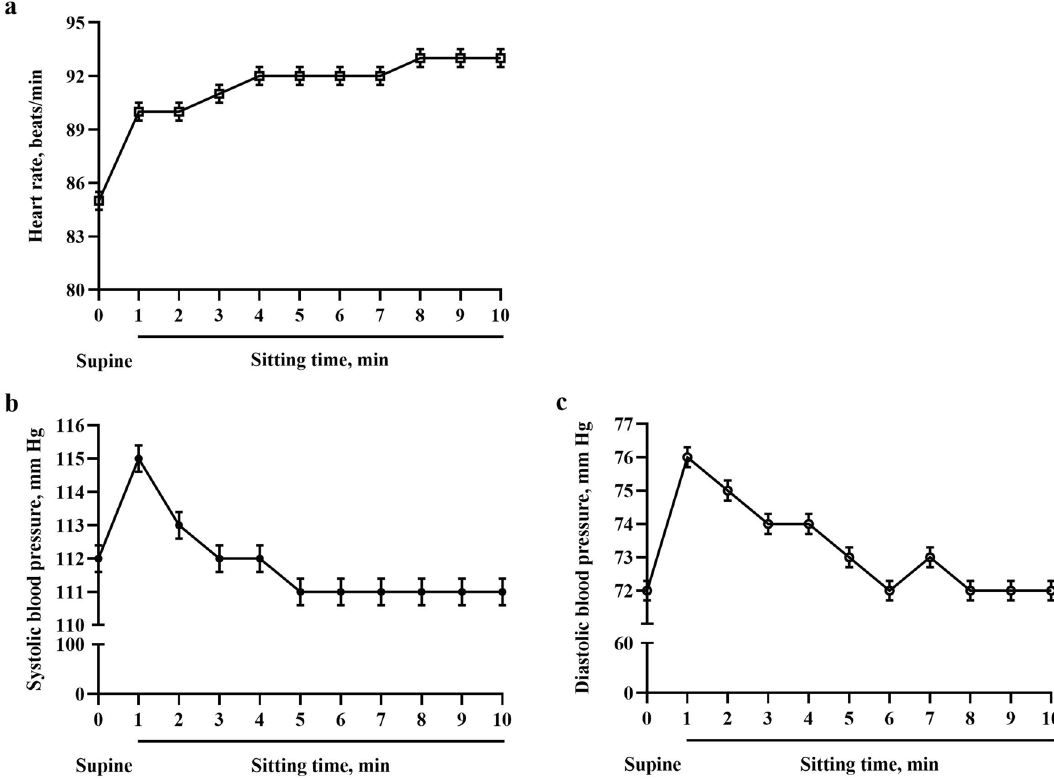
Figure 2. Changes in hemodynamics for children and adolescents in active sitting test. Changes in ( a ) heart rate, ( b ) systolic blood pressure and ( c ) diastolic blood pressure. Data are mean ± SE. Heart rate and blood pressure changed promptly with postural change from supine to sitting and then reached a relatively stable